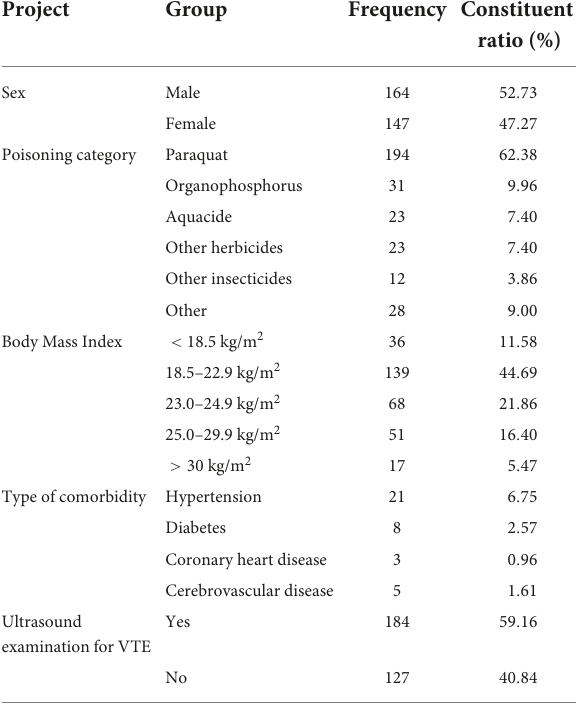
TABLE 1 Patient demographic characteristics.